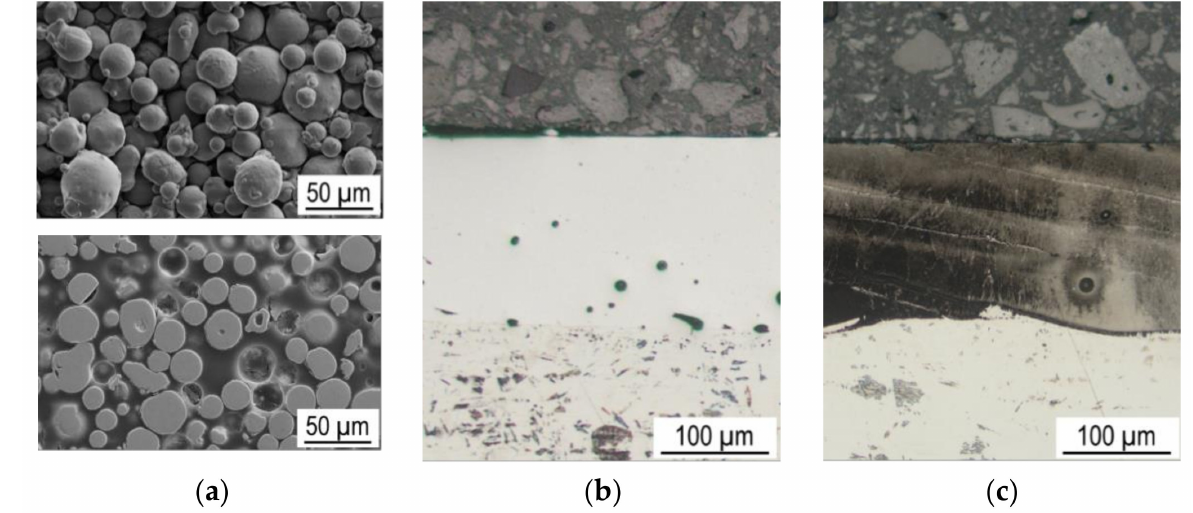
Figure 1. SE images of a feedstock material, as well as optical microscope images of the diamond smoothed HS-LMD coating systems in cross-sectional view after etching. ( a ) CrFeCoNi powder, ( b ) CrFeCoNi coating, ( c ) AlCrFeCoNi coating.